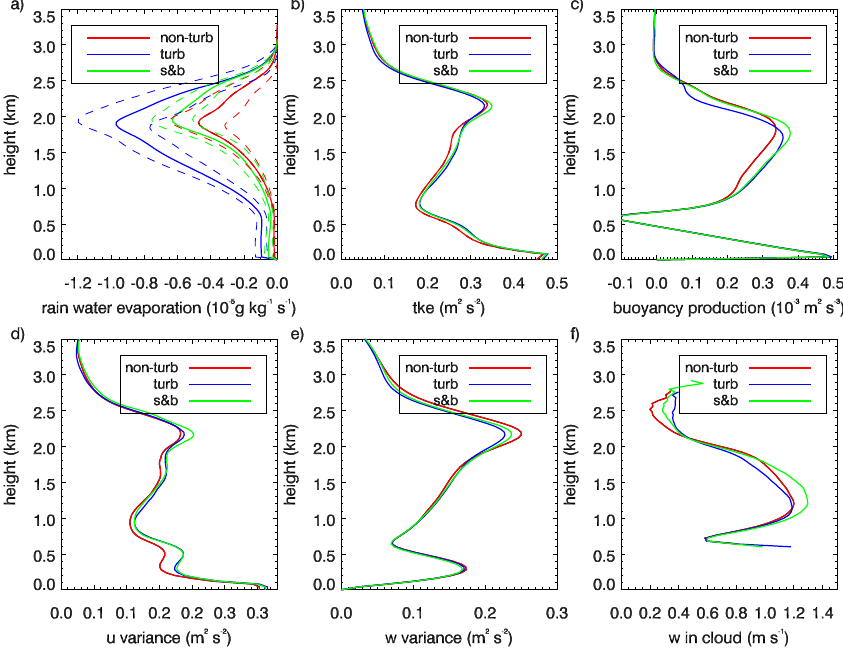
Figure 5. As in Fig. 3 except for (a) rain water evaporation (gkg − 1 s − 1 ) , (b) turbulent kinetic energy (m 2 s − 2 ) , (c) buoyancy production of turbulent kinetic energy (10 − 4 m 2 s − 3 ) , (d) variance of u component of horizontal wind (m 2 s − 2 ) , (e) variance of vertical velocity (m 2 s − 2 ) and (f) conditional average of vertical velocity inside clouds (ms − 1 ) . The coloured dashed lines in (a) represent the ± standard deviation from the temporal means, with the rain water evaporation being the only field that shows significantly different